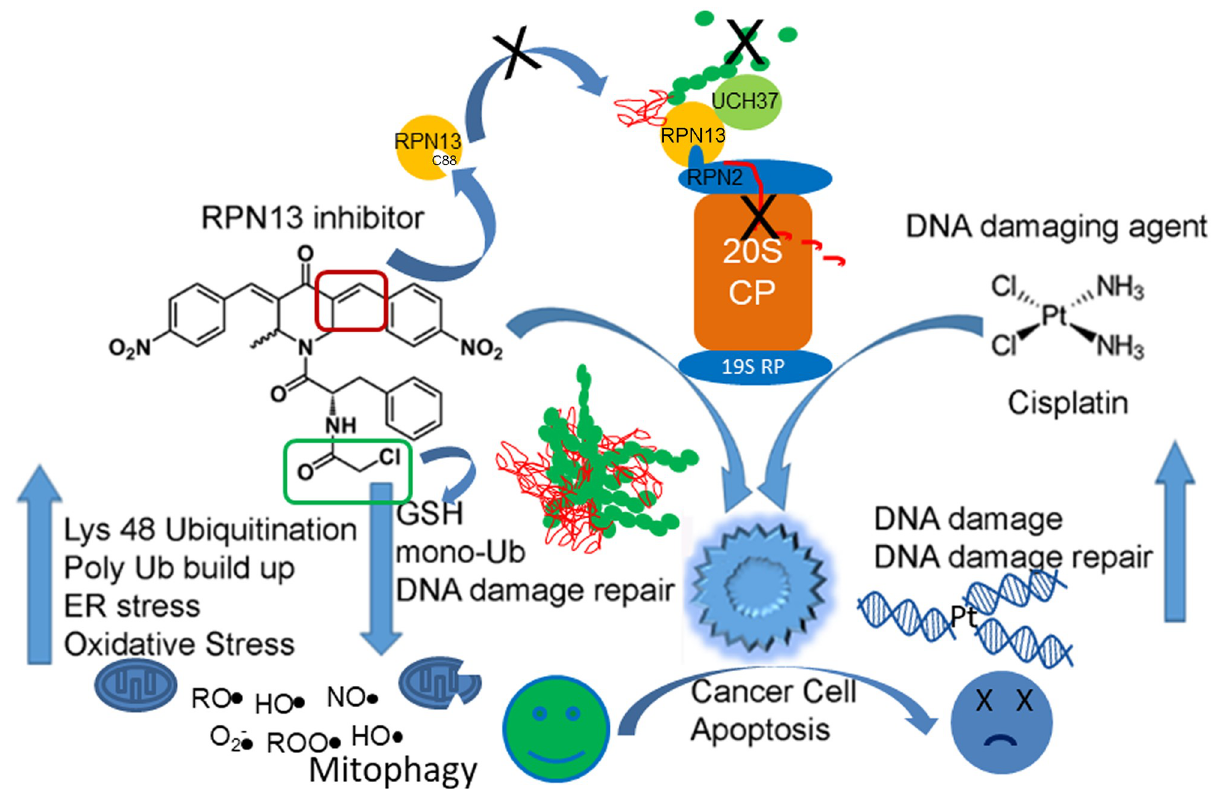
Fig 10. Scheme for the proposed mechanism of action of RPN13 inhibitors and synergistic cytotoxicity observed in combination with DNA damaging agents like cisplatin.